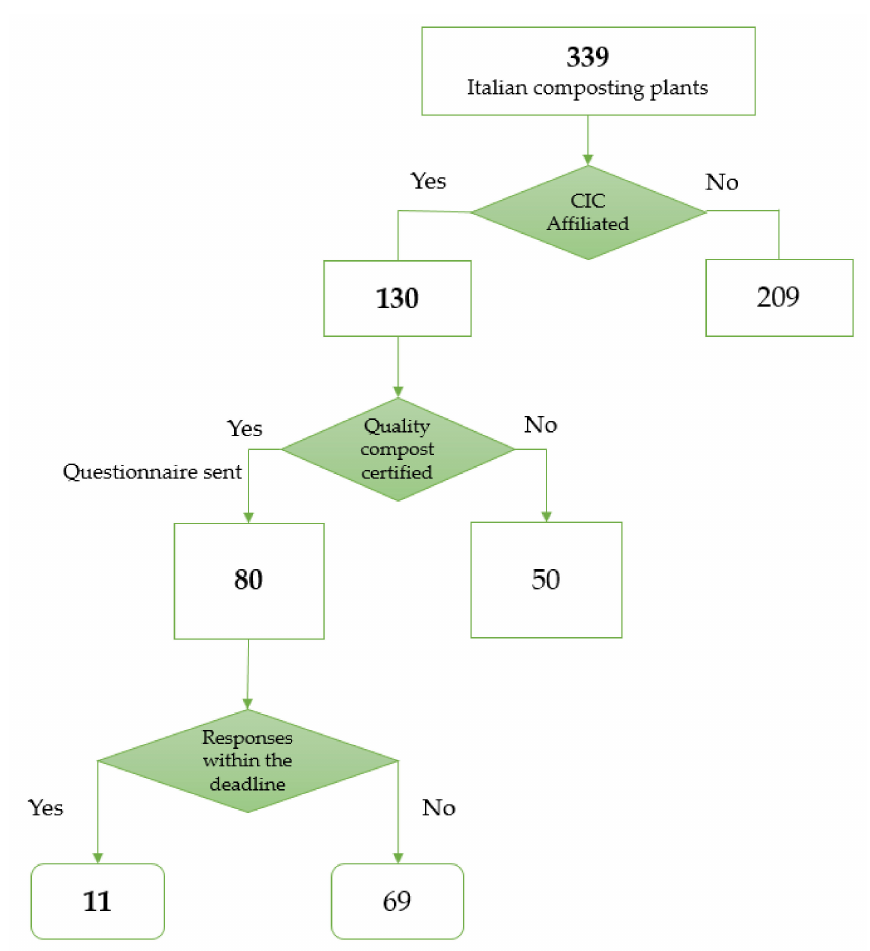
Figure1. Flowchartoftheselectionprocessoftheplants. CIC =